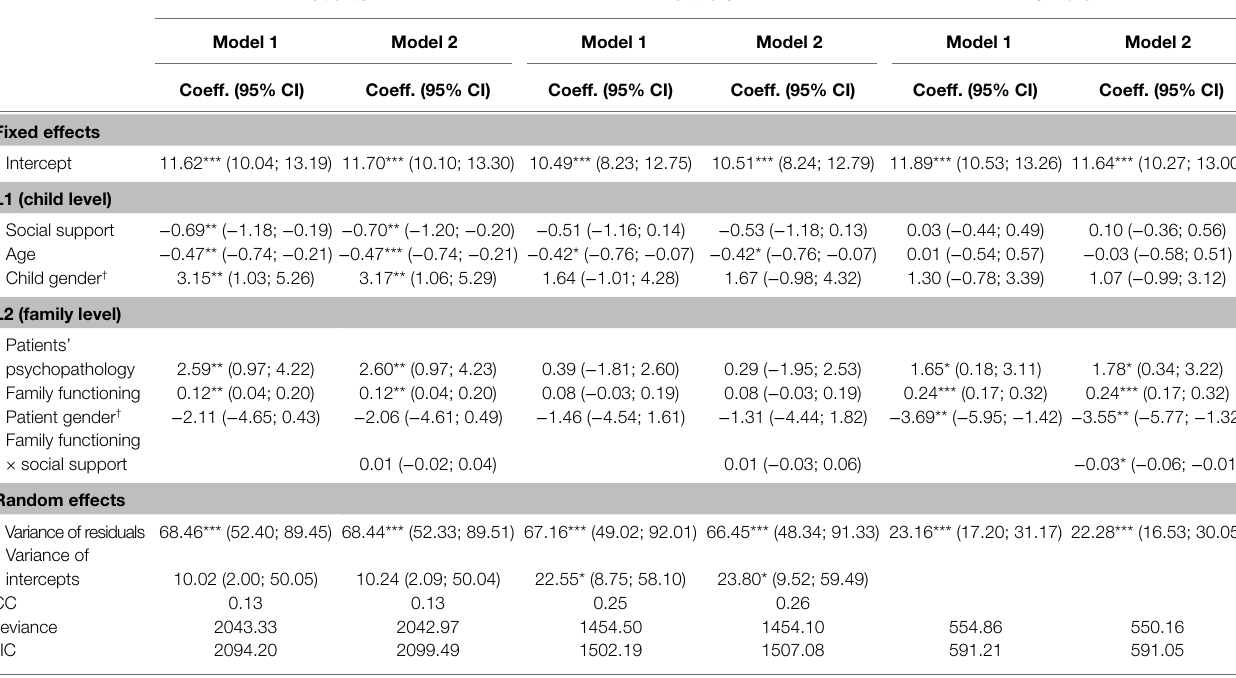
Linear mixed models with raw scores from the Child Behavior Checklist and Youth Self-Report. Coeff., unstandardized coefficients; ICC, intraclass correlation coefficient; BIC, Bayesian Information Criterion; grand-mean centering for all continuous regressors. a n = 285 children nested in 192 families. b n = 200 children nested in 127 families. c n = 94 children nested in 75